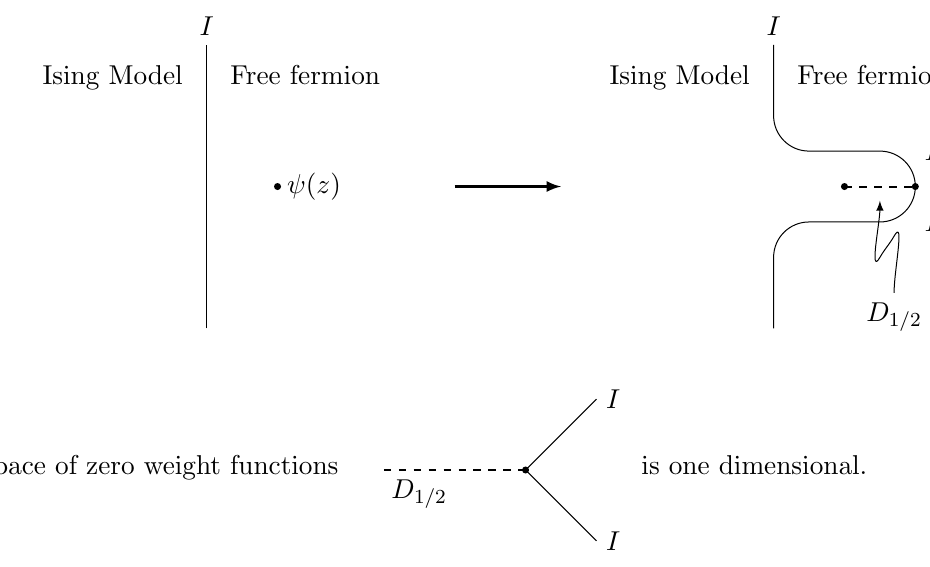
Figure 3 . The (cid:12)eld in the free-fermion model is realised as a defect-creation operator in the Ising model. The associated space of three-defect junctions is one-dimensional.